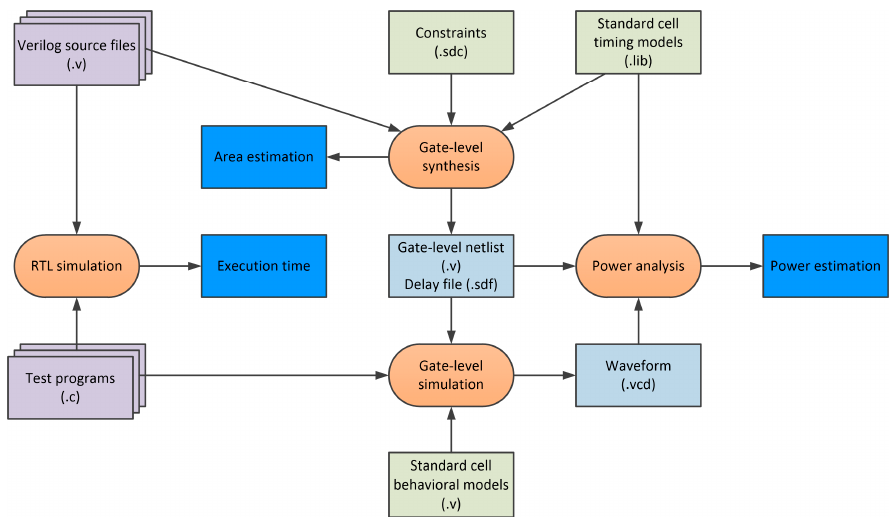
Figure 9. Execution time, area estimation, and power estimation flow.